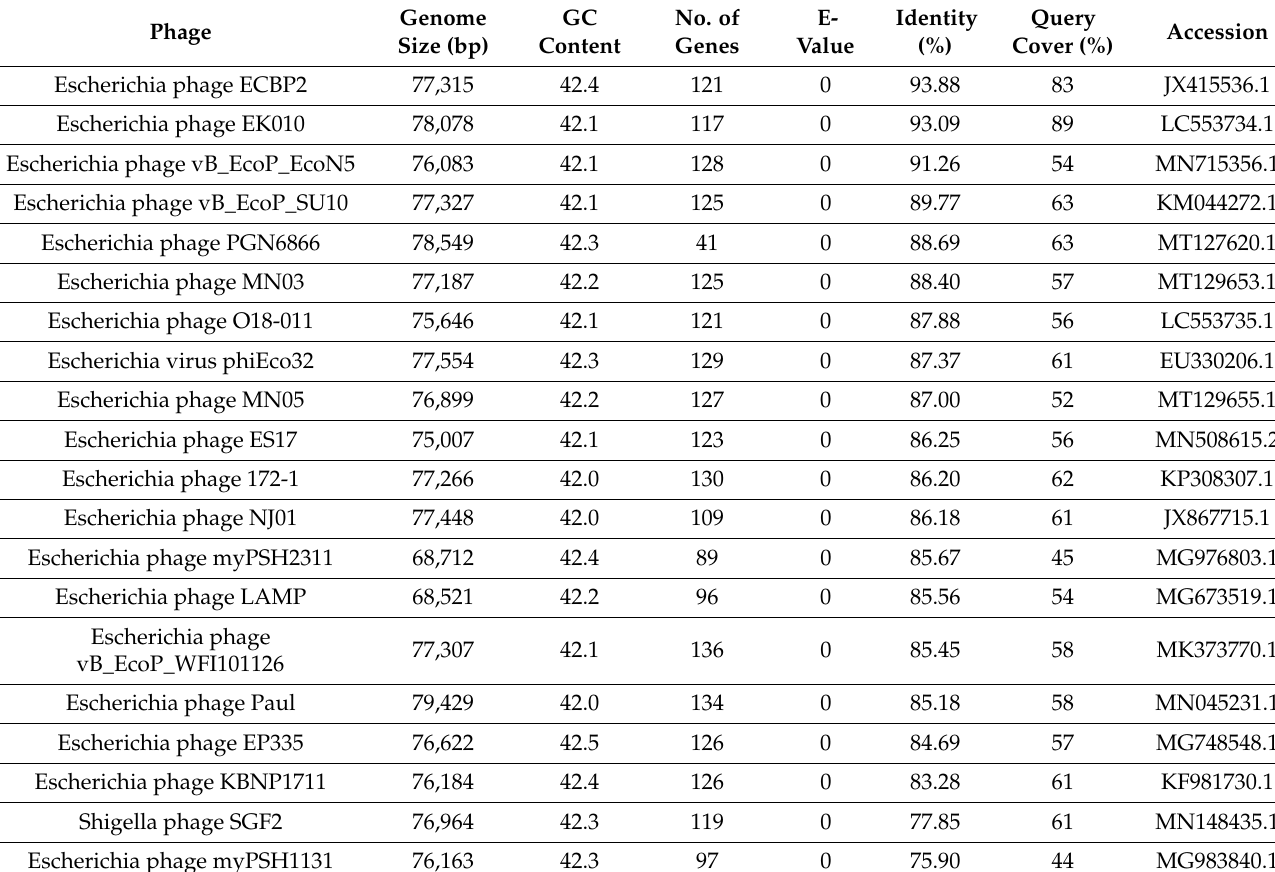
Table 1. Genome nucleotide comparison of SU7 and the Kuraviruses presenting the C3 morphotype. Genome Phage Size (bp)